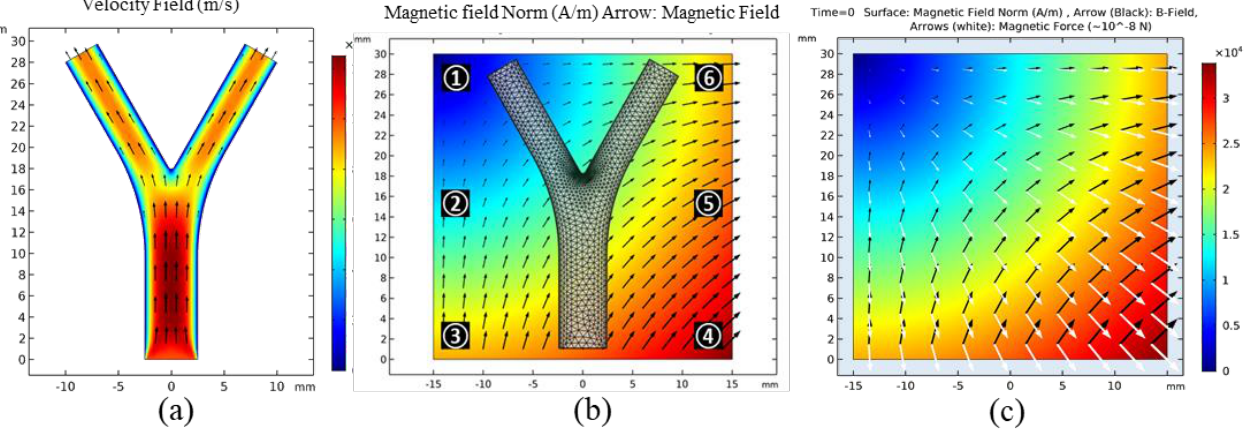
Figure 2. ( a ) Fluid velocity profiles in 2D vessel; ( b ) Meshed 2D bifurcation vessel along with FFP positions in the region of interest (ROI). ( c ) Comparison of magnetic and |𝛻𝐵| .